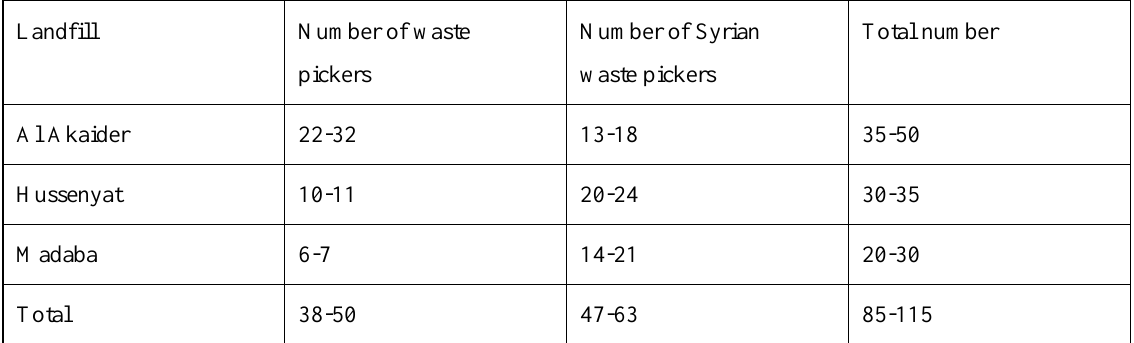
Table 1. The number of Jordanian and Syrian waste pickers.